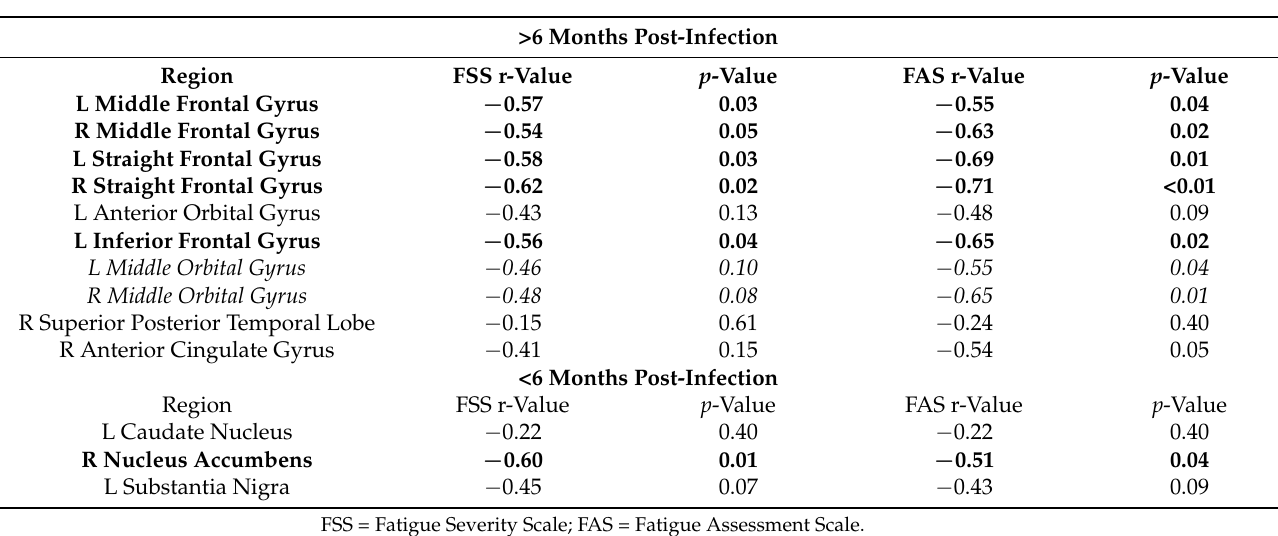
Table 3. Results of the Pearson’s correlations between FAS or FSS and RRV of specific brain regions in people >6 months post-infection (top) and people <6 months post-infection (bottom). Regions with significant correlations in both fatigue scales are bolded , and regions with a significant correlation in only one fatigue scale are italicized .